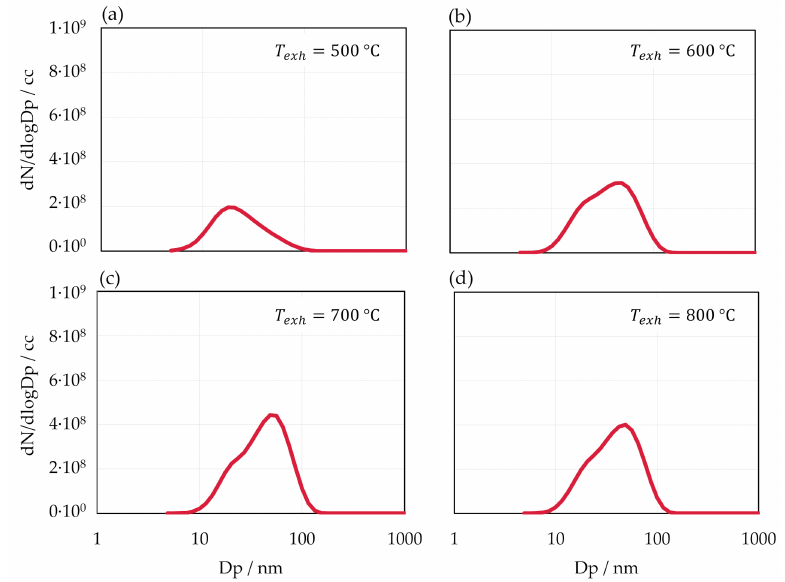
. m exh = 60 g and s